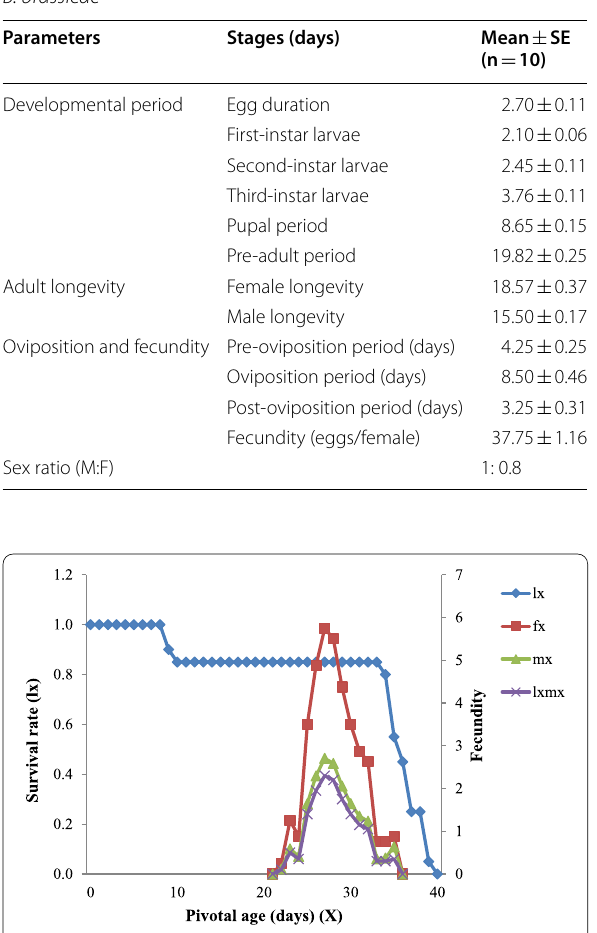
Fig. 1 Age-specific survival rate ( l x ), female age-specific fecundity ( f x ), age-specific fecundity (m x ) and age-specific maternity ( l x m x ) of S. pyrastri on B. brassicae